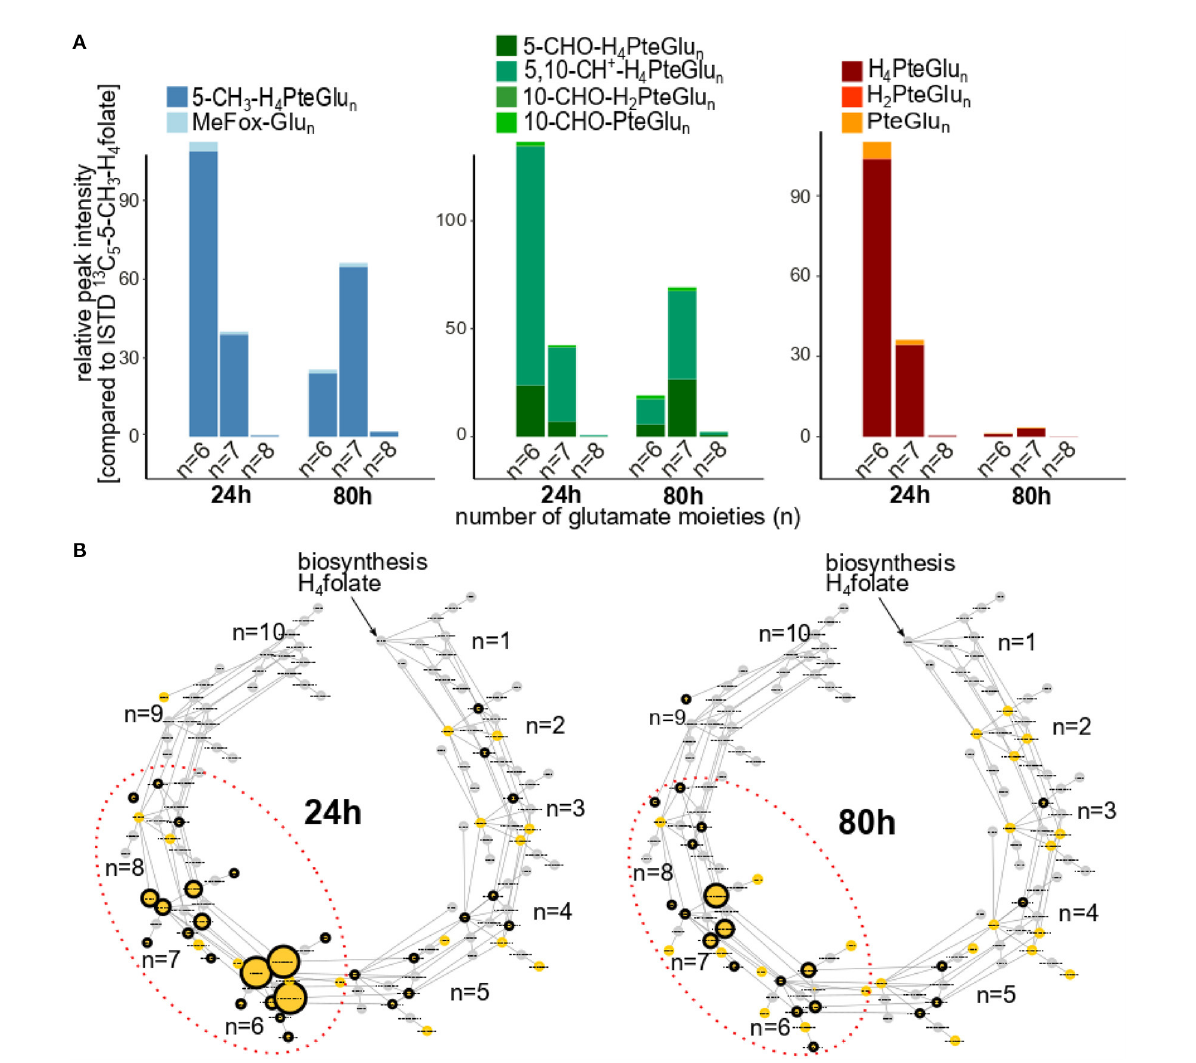
FIGURE4 Profiling of folate metabolites in cultivated TUM68 ® yeast after 24 and 80h of cultivation time analyzed by UHPLC-Q-ToF-MS; with (A) detailed distribution of the main polyglutamates ( n = 6–8) depicted as relative peak intensity compared to the added internal standard (ISTD) [ 13 C 5 ]-5-CH 3 -H 4 folate; with methylated polyglutamates 5-CH 3 -H 4 PteGlu 6 − 8 (dark blue) and their corresponding oxidation products MeFox-Glu 6 - 8 (light blue); formylated polyglutamates 5-CHO-H 4 PteGlu 6 − 8 (dark green) and 5,10-CH + -H 4 PteGlu 6 − 8 (leaf green) and their corresponding oxidation products 10-CHO-H 2 PteGlu 6 − 8 and 10-CHO-PteGlu 6 − 8 (lighter greens); unsubstituted polyglutamates H 4 PteGlu 6 − 8 (dark red) and their corresponding oxidation products H 2 PteGlu 6 − 8 (red) and PteGlu 6 − 8 (orange), (B) folate C 1 polyglutamate metabolism starting at H 4 folate and additional incorporation of one glutamate moiety for each subgroup represented by different indices n defining the length of the polyglutamate tail. Different nodes represent the diversity of folate vitamers in different polyglutamate states. Edges represent enzymatic transformations within the cell between those polyglutamates. Nodes shown in yellow could be determined on MS 1 level, whereas nodes highlighted by an additional black circle were further identified on MS 2 level. The size of the nodes displays the relative peak intensity as mean of all replicates